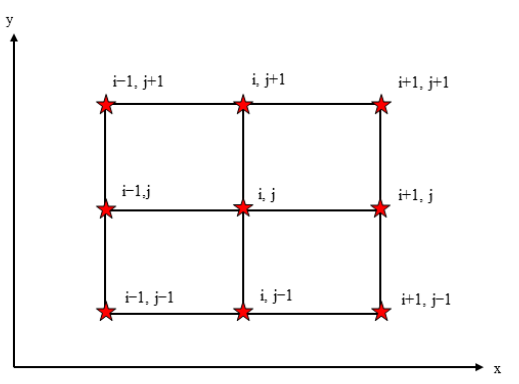
Figure 1. Distribution of the calculation points.